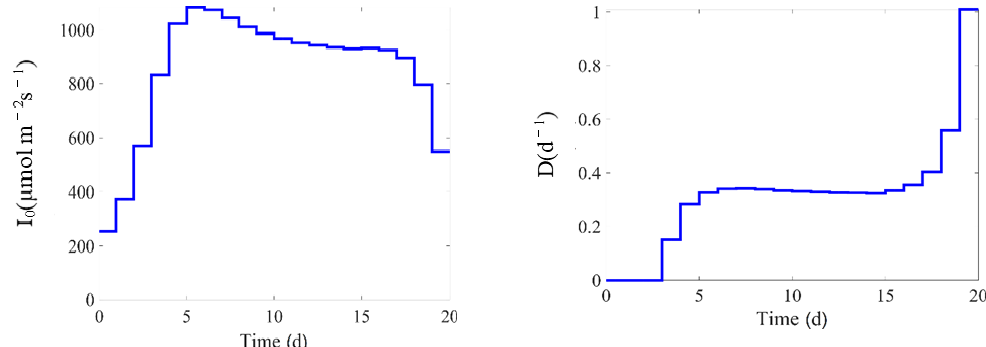
Figure 8. Manipulated variable moves generated by NMPC for the photon flux density ( 𝐼 0 ) and dilution rate ( 𝐷 ).